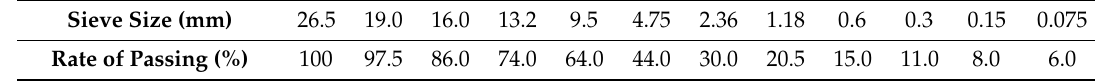
Table 1. Gradation of AC-20 and high-modulus asphalt concrete (HMAC)-20.